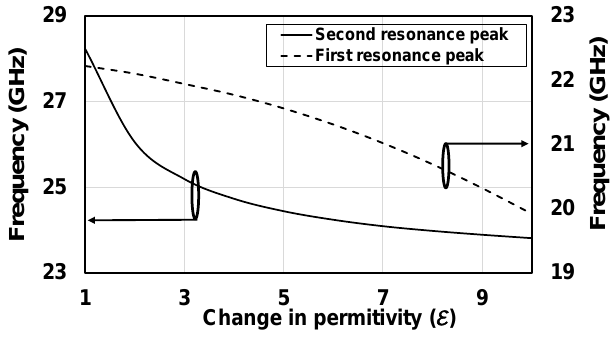
Fig.7. Effect of permittivity on sensitivity of resonance peaks